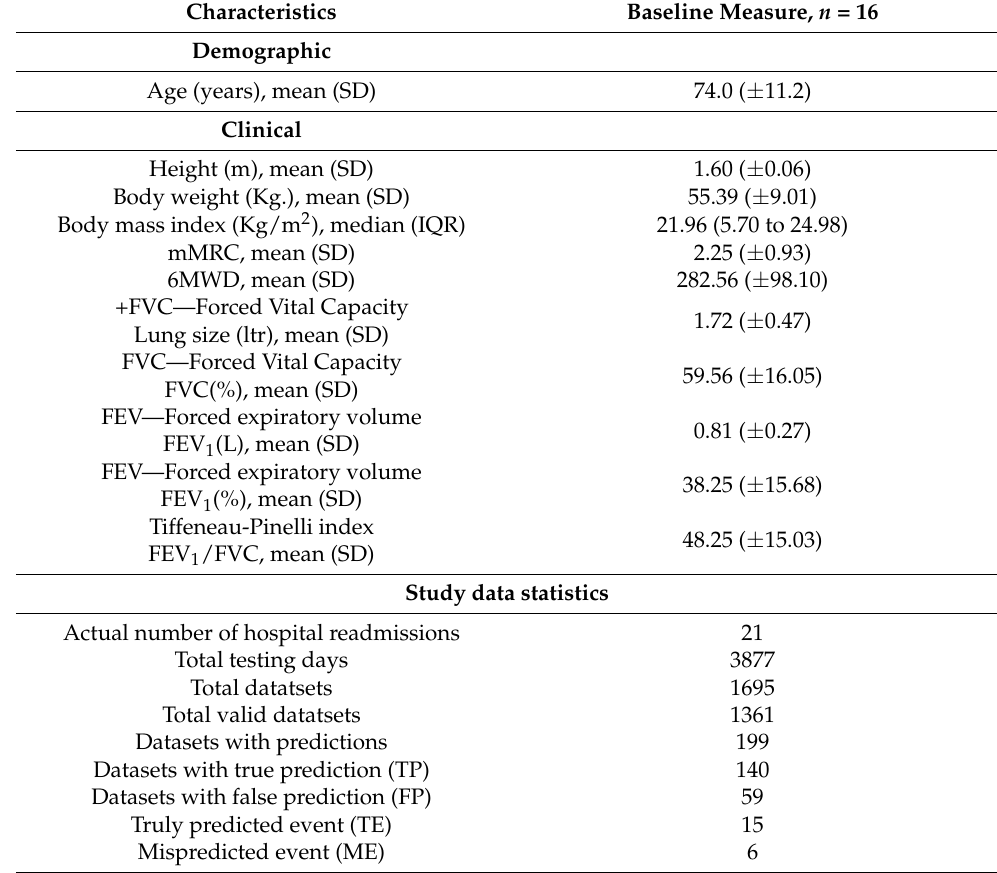
Table 2. Data collection and results